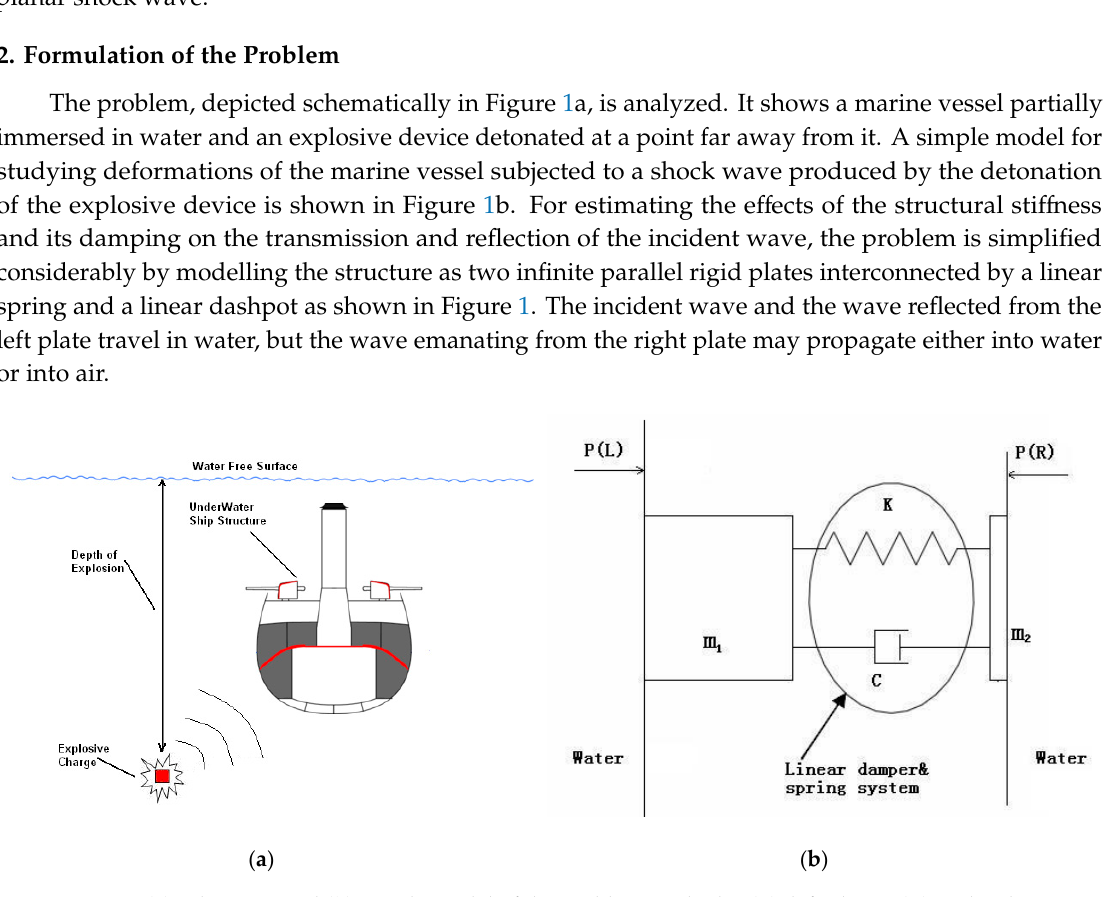
Figure 1. ( a ) Schematic and ( b ) simple model of the problem studied. P(L), left plate; P(R), right plate.